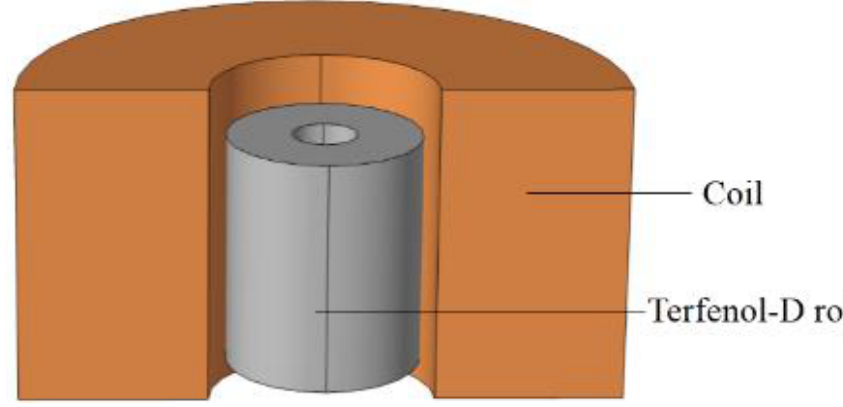
Figure 2. Working model of a rod vibrator.